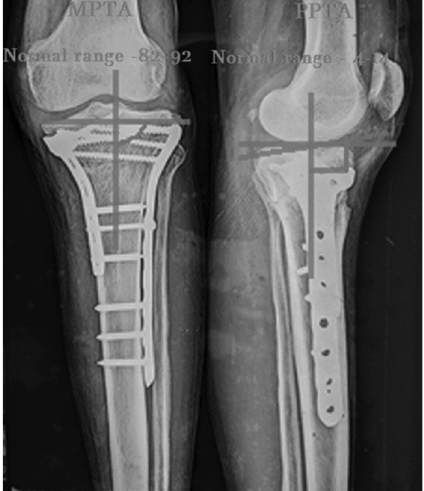
Radiographic measurements of MPTA and PPTA angle. Fig. 1: